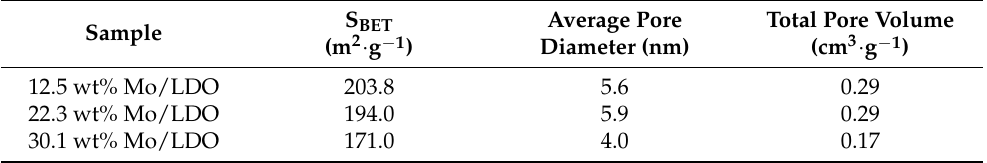
Table 1. Textural properties derived from the different Mo/LDO catalysts.